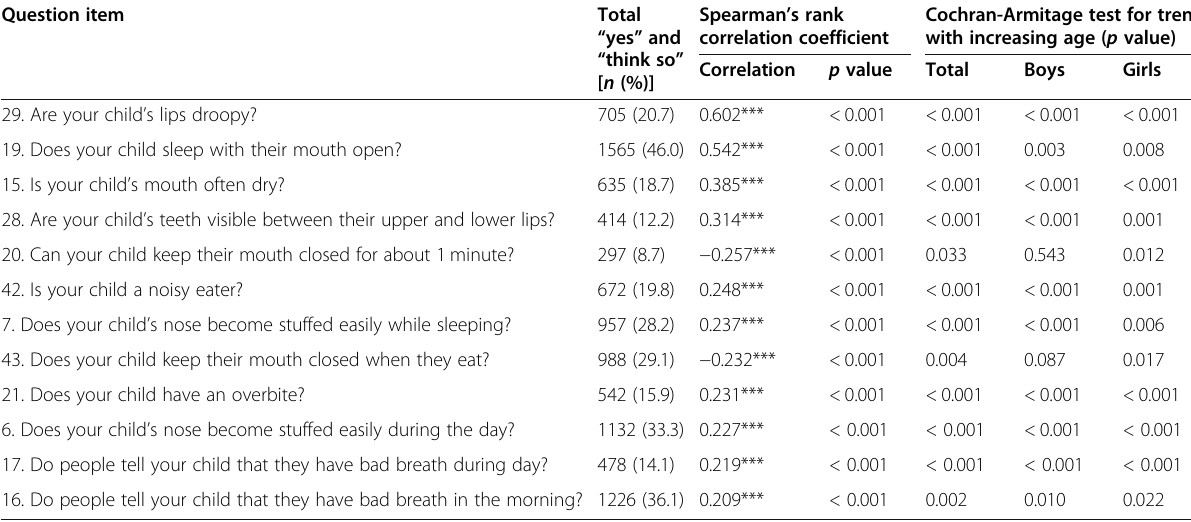
Table 6 Correlation and trend with age between 12 question items and an incompetent lip seal Question